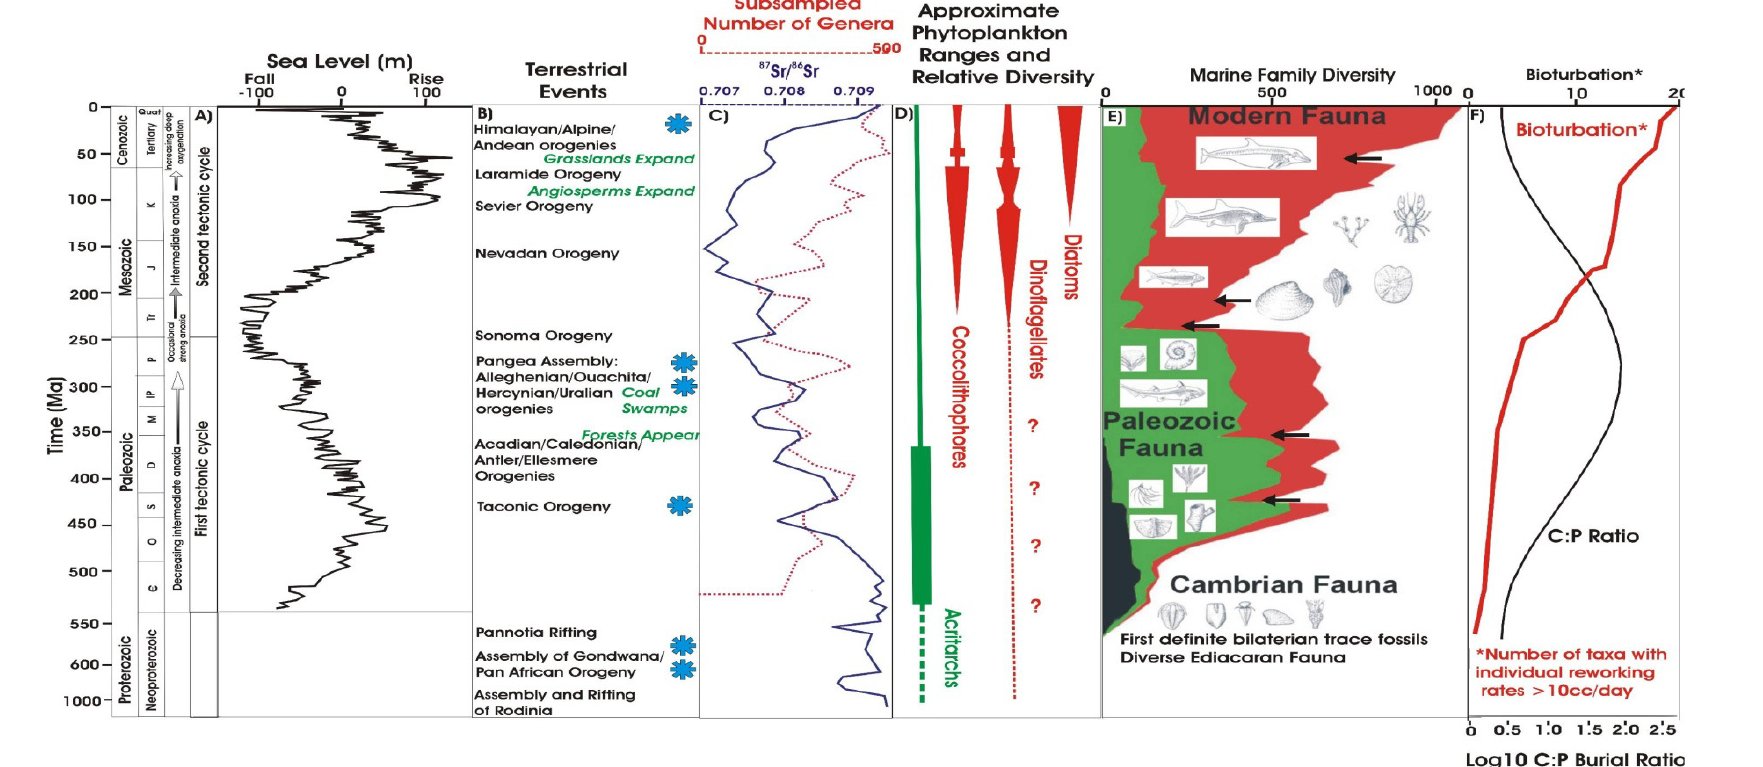
Figure 1. Marine biodiversity and environmental change through the late Proterozoic and Phanerozoic (adapted from [19]). ( a ) Sea level, tectonic cycles, and relative oxygen levels; ( b ) Terrestrial events: orogenies and land plant evolution (italics). Snowflakes indicate times of well-developed glaciers; ( c ) Comparison of mean Phanerozoic global isotopic signature of 87 Sr/ 86 Sr (dashed) and most recent calculation of subsampled number of marine genera (dotted; [2]). Original 87 Sr/ 86 Sr data from [20,21]). Increasing strontium isotope ( 87 Sr/ 86 Sr) are used as a general qualitative indicator of